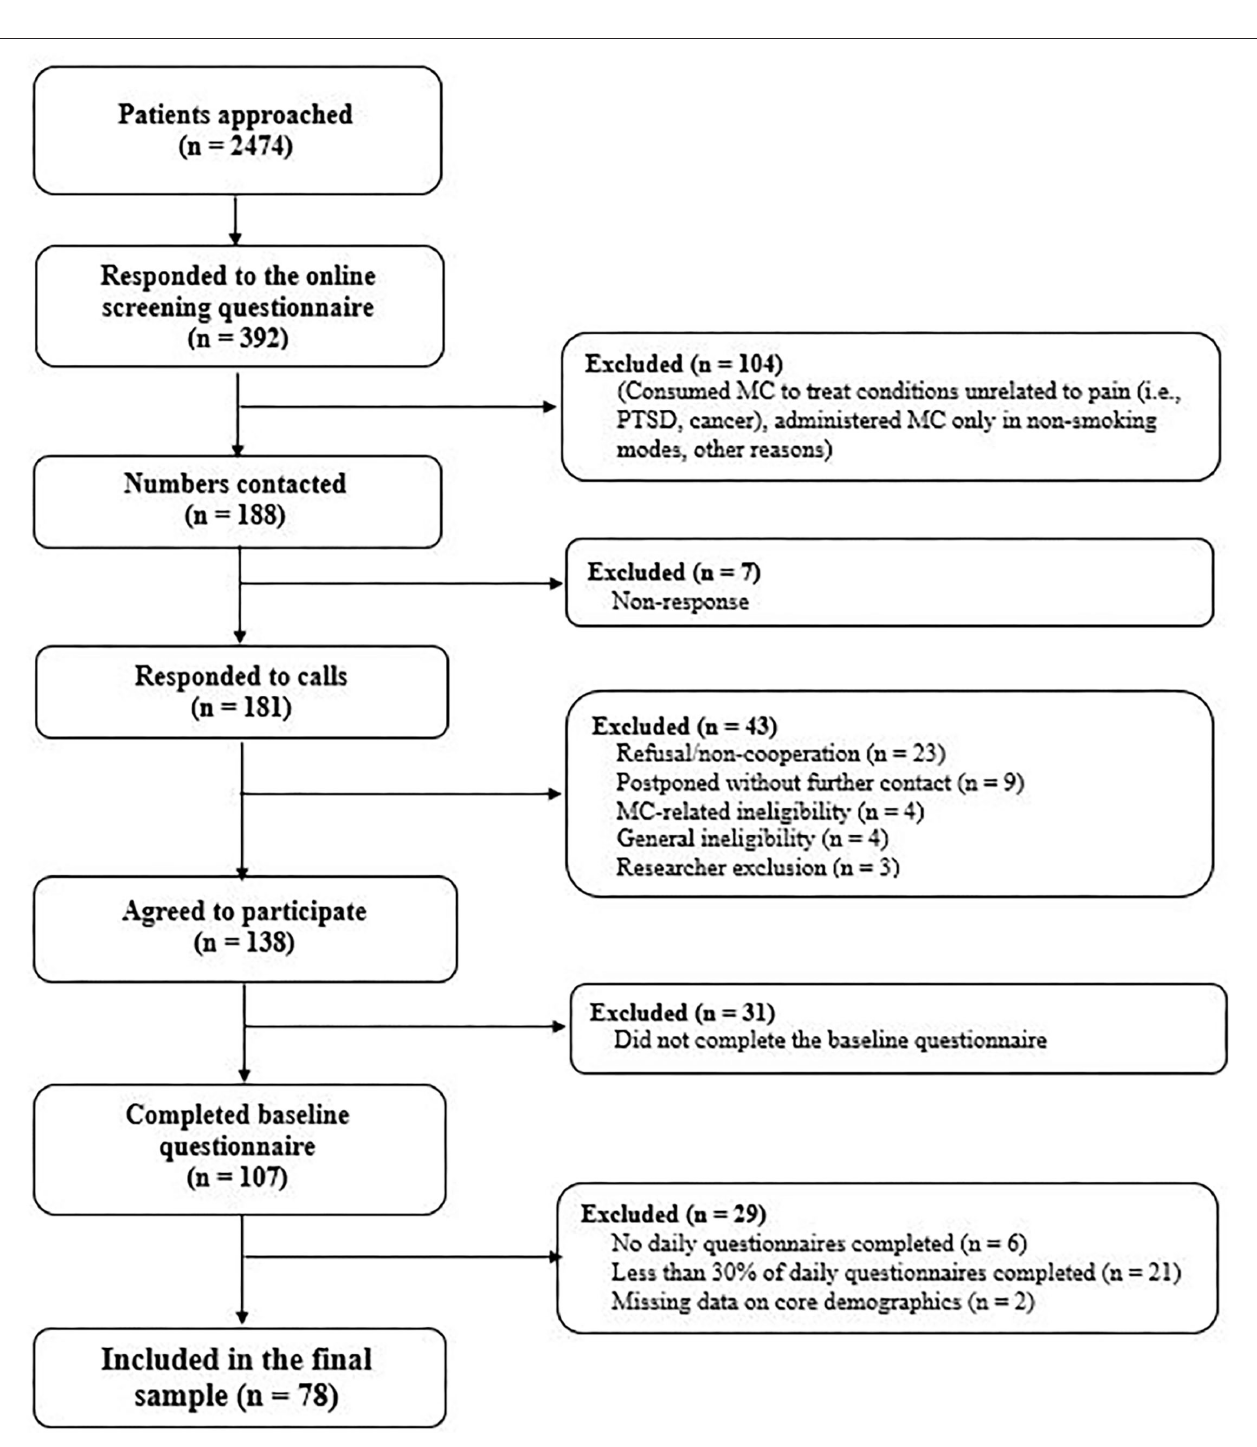
FIGURE 1 | Flow of patient through the